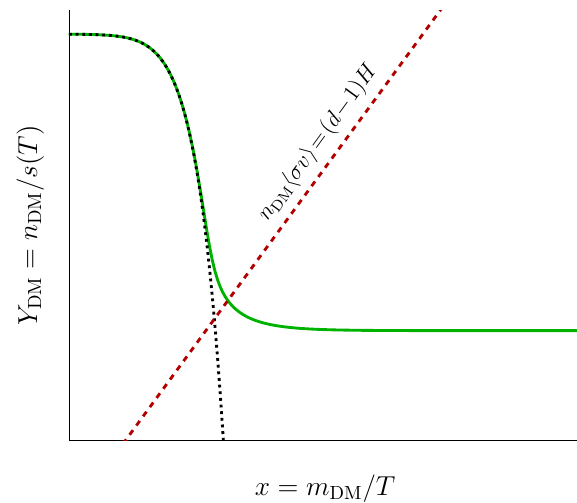
FIG. 2. SM-neutrinos, total probability of (cid:28) -exit at the Earth surface per angle under the horizon, for an incoming Figure 5 . Evolution of the dark-matter yield Y DM = n DM =s as a function of x = m DM =T in the neutrino of energy E (cid:23) = 10 EeV. standard thermal scenario, in 4 dimensions (green solid line). The black-dotted line represents the value that the yield would follow if thermal equilibrium could be maintained all along the history of the universe. Freeze-out takes place when interactions with the Standard-Model particles are too weak, as compared to the expansion rate of the universe (after crossing of the red dashed